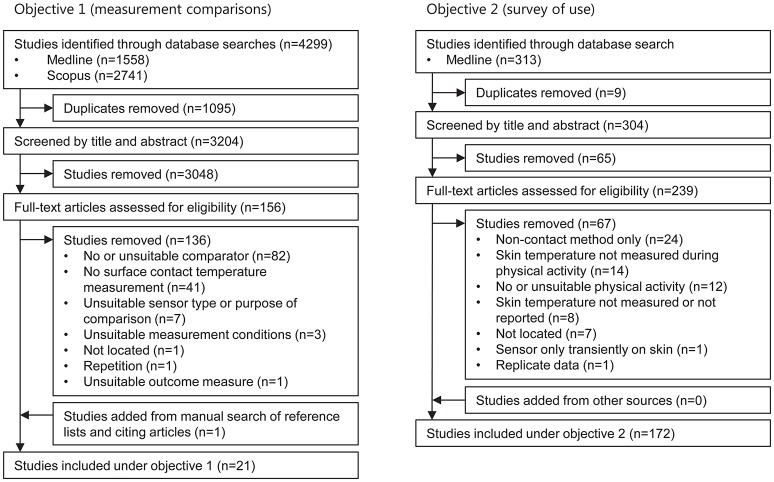
Screening flow diagram for objectives 1 and 2. Only one reason for exclusion is given per study but multiple reasons may have applied.